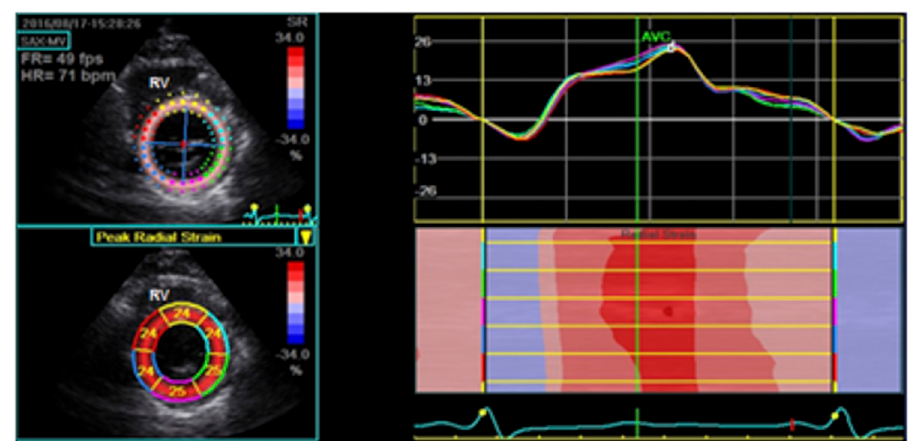
upper panel); M-mode color-coded display of peak systolic strain (right lower panel).